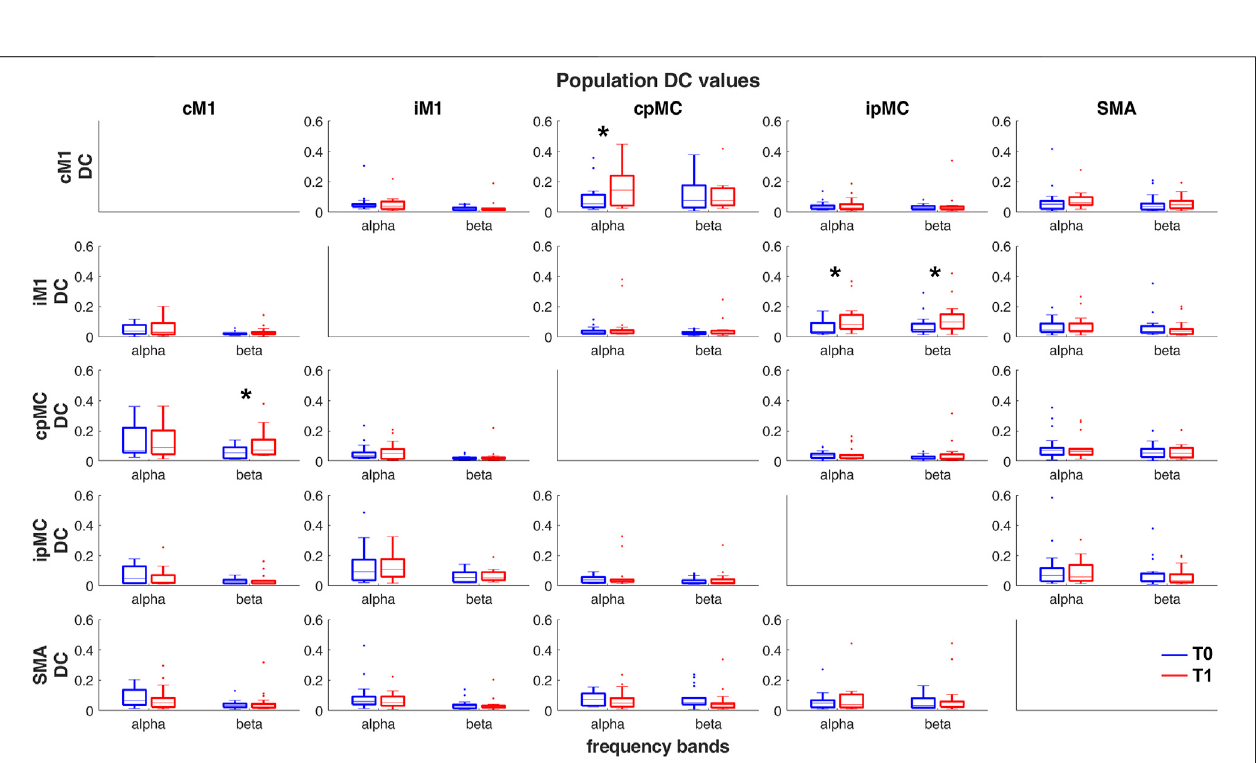
FIGURE3| Population ’ sDCvaluescalculatedin α and β frequencybands,inT0(blue)andT1(red)acquisitions.Eachsub-plotrepresentsapairofROIsconnection c ij . Columns j : senders; rows i : receivers. * Signi fi cant variations DC T1 - DC T0 (one-tailed paired Wilcoxon ’ s test, p < 0.05, without correction for MC).